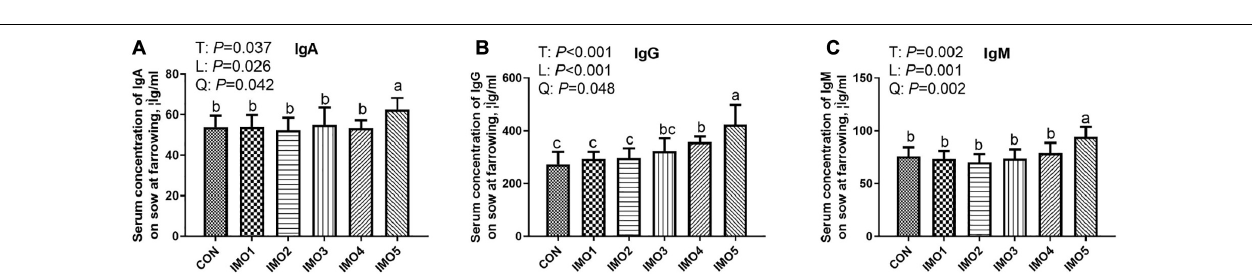
regions of bacterial 16S rRNA genes generated 1,094,499 and ( Supplementary Table 2 ). On the basis of 97%